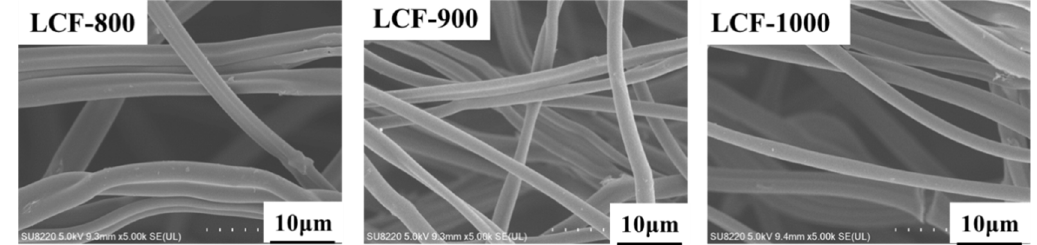
Figure 1. S urface morphologies of the lignin-based carbon fiber (LCF) mats prepared at different Figure 1. Surface morphologies of the lignin-based carbon fiber (LCF) mats prepared at di ff erent carbonation temperatures. carbonation